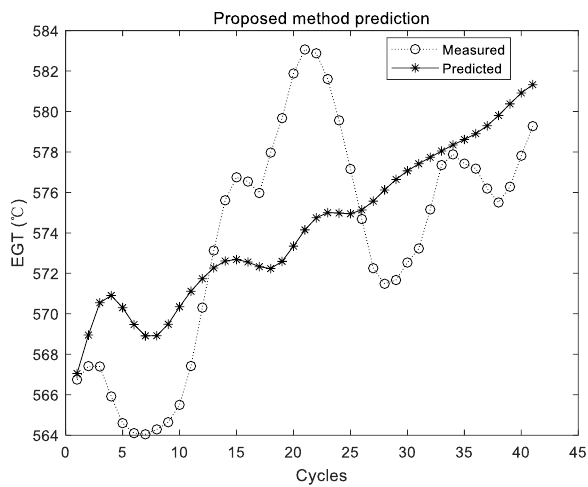
Figure 12. Experimental results of the proposed method using the second group of data.